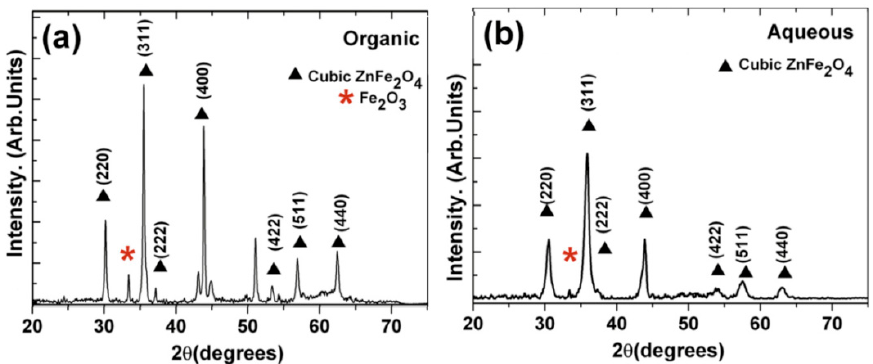
Figure 4. X-ray diffraction spectra of deposited zinc ferrite films using ( a ) ethylene glycol, and ( b ) water as precursor solvents. Reproduced with permission from [10], Elsevier, 2012.